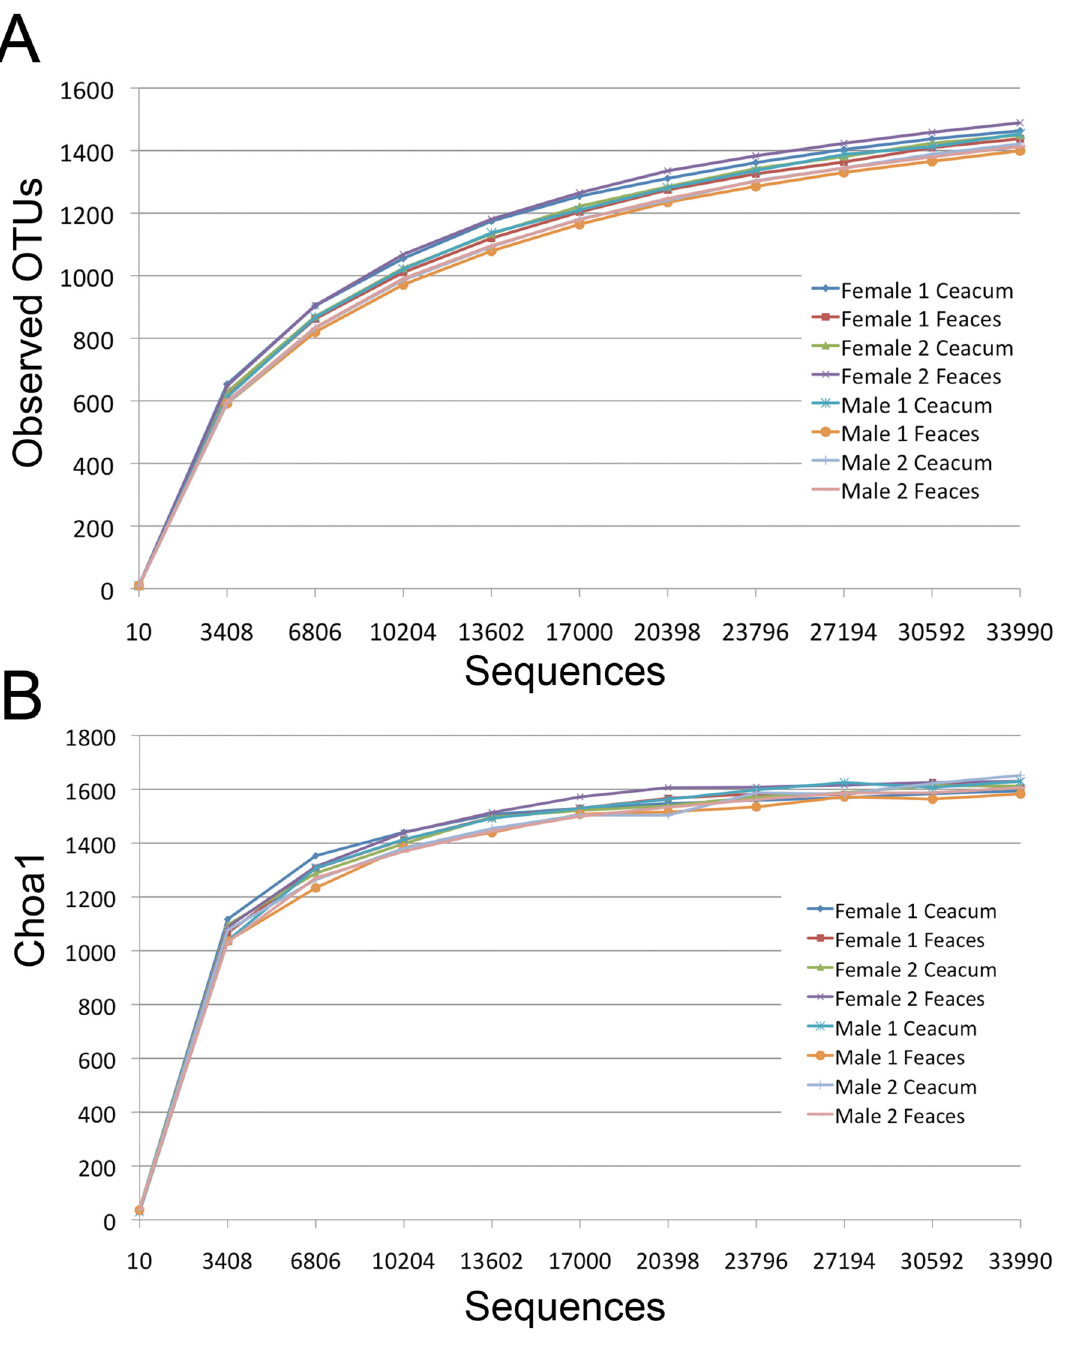
Fig 1. Rarefaction curves showing the A) Observed OTUs,B) Choa1 asa function of sequencing effort. Sequences from each samplewere randomly sub-sampled to the lowest number of sequences contained in all samples